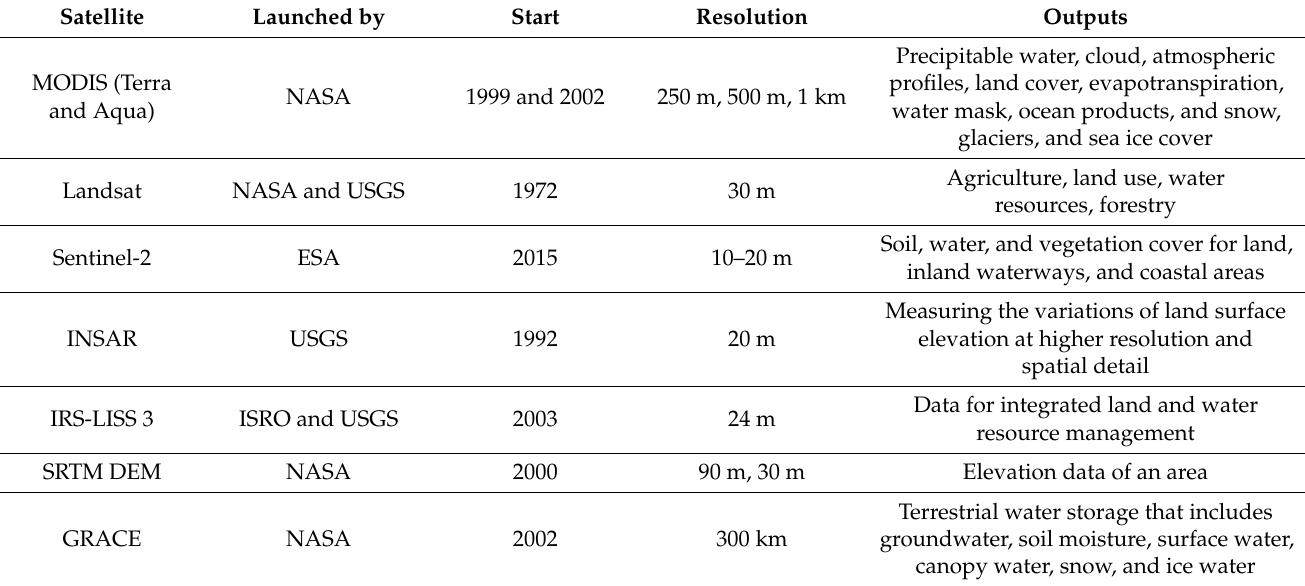
Table 1. Summary of Satellites used in this review